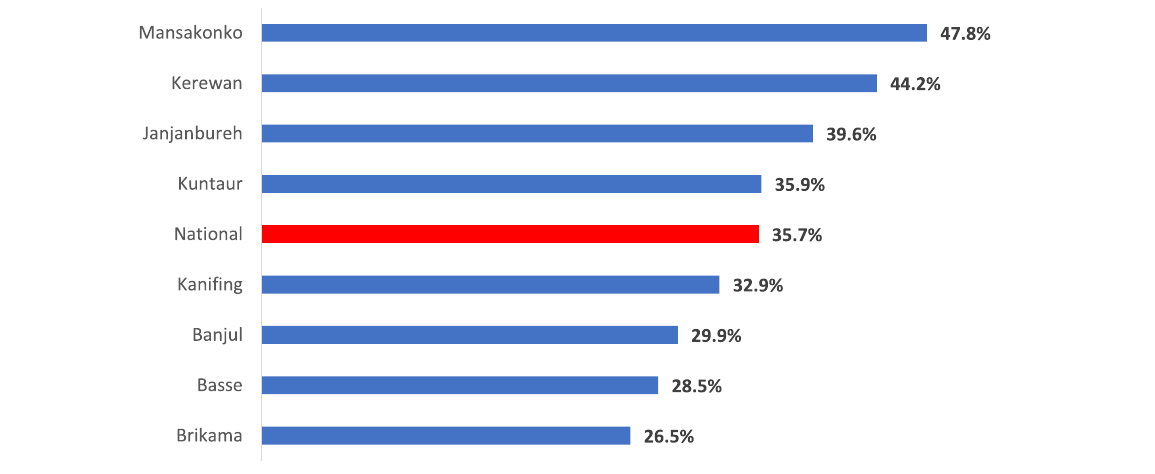
Fig. 1 Local government areas discordance of mother and newborn skin-to-skin contact in The